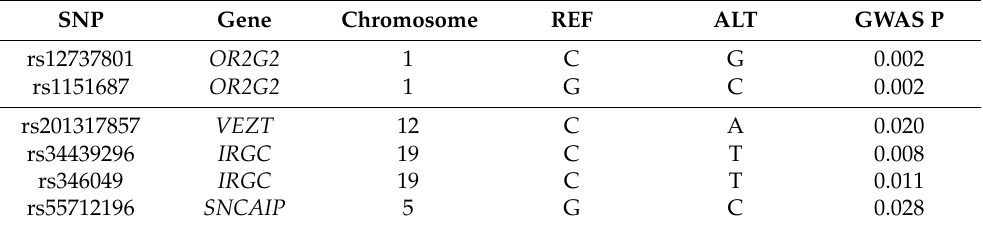
Table 3. Verification of gene-based association analyses results in gene region. SNP Gene